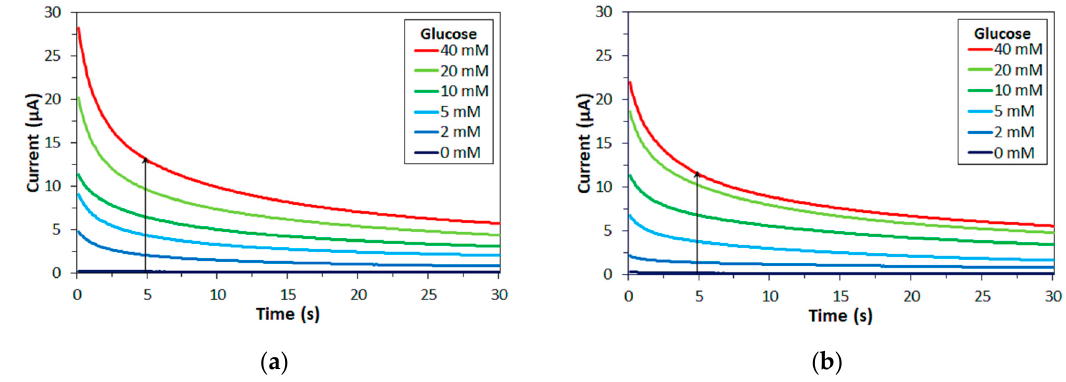
Figure 2. Representative time courses of glucose measurements with enzyme electrodes. Mediator: mPMS. Enzyme: ( a ) FADGDH γαβ (QY), ( b ) Af GDH (arrow: increasing glucose concentration).